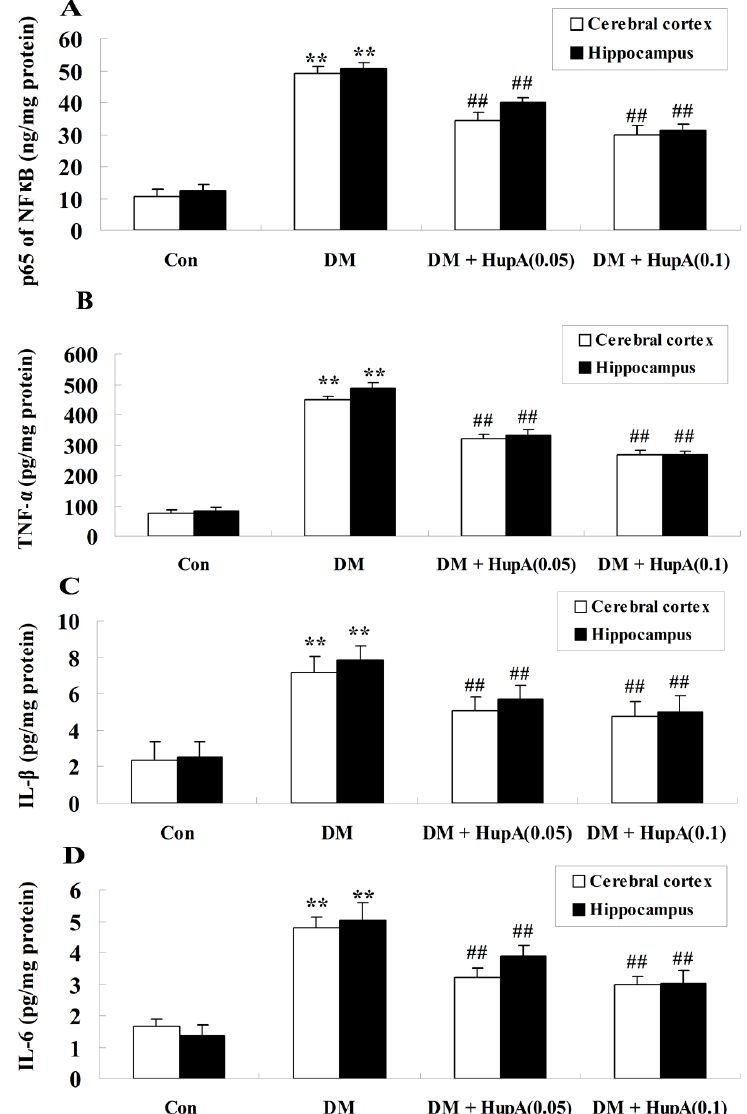
Figure 7. Effects of HupA on the inflammatory cytokines in cerebral cortex and hippocampus of control and diabetic rats ( n = 8, mean ± S.D.). ( A – D ) displayed NF κ B p65 subunit, TNF- α , IL-1 β and IL-6 levels in the cerebral cortex and hippocampus of control and diabetic rat brain. ** p < 0.01 compared with Con group; ## p < 0.01 compared with DM group. Con, control; DM, diabetes; DM + HupA (0.05), huperzine A (0.05 mg/kg)-treated; DM + HupA (0.1), huperzine A (0.1 mg/kg)-treated